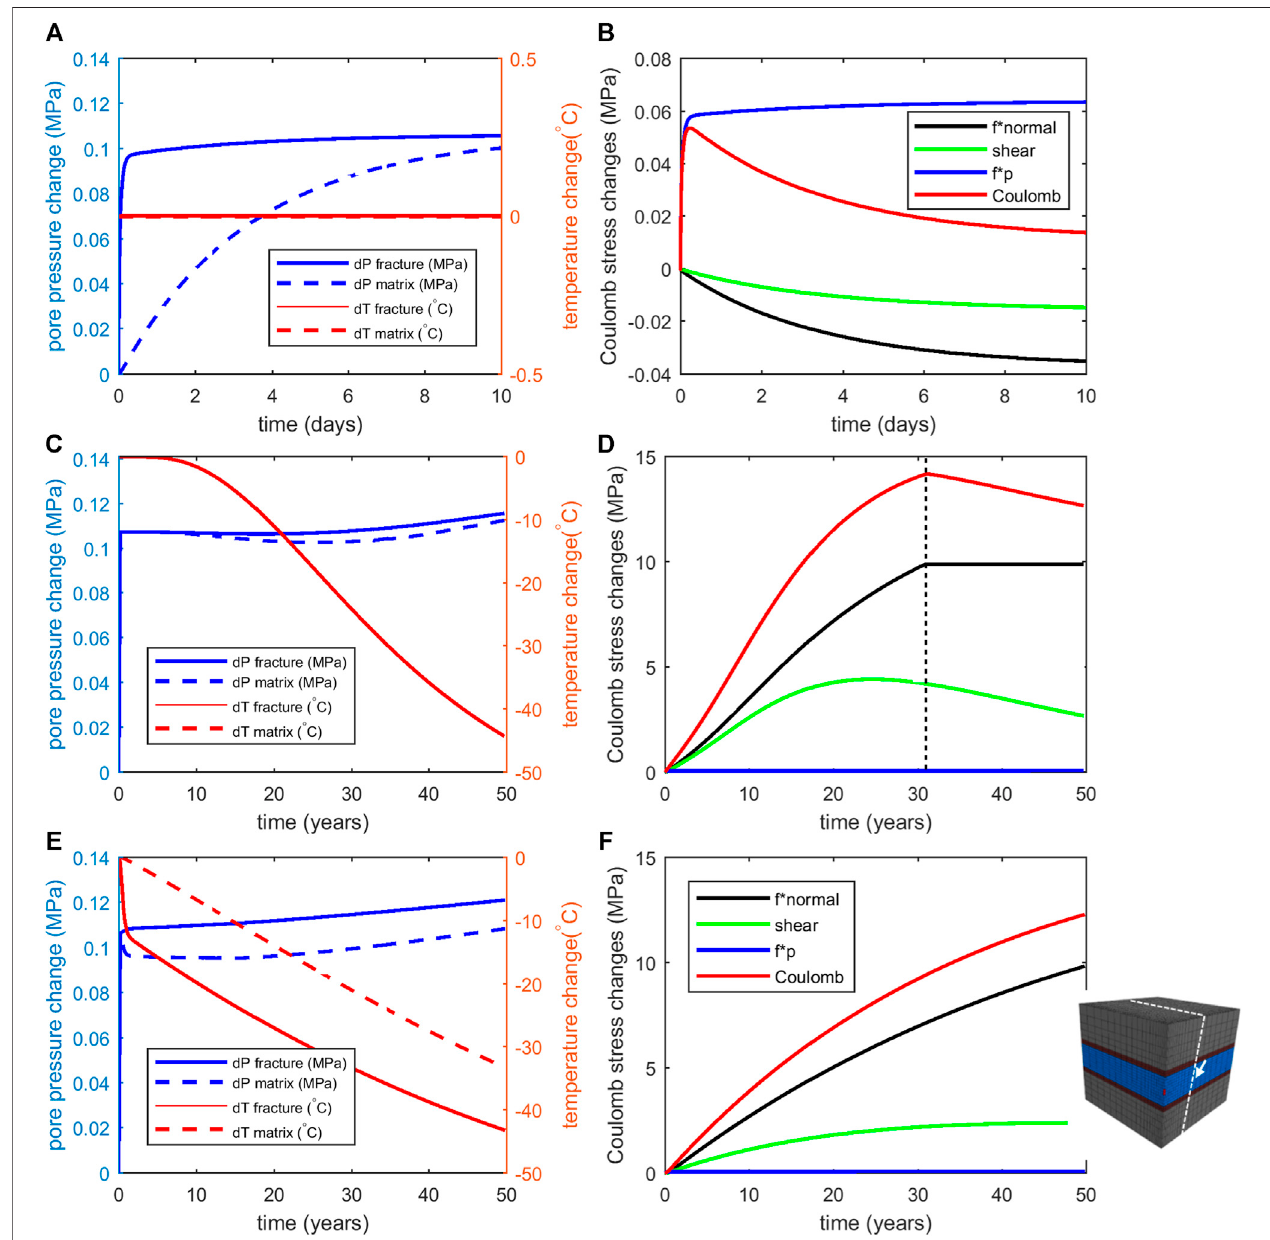
FIGURE 4 | Pressure and temperature changes on the fault (central, mid-height location) at 300 m distance from the injection well. (A) pressure and temperature changeduring fi rst10 days – fracturedistance200 m, (B) contributionofdirectpressureeffect(blue),totalnormalstresschanges(black),shearstress(green)toCoulomb stress change on the fault (red), fracture distance 200 m, during fi rst 10 days, (C) pressure and temperature change during total period of 50 years – fracture distance 2 m, (D) contribution of direct pressure effect (blue), total normal stress changes (black), shear stress (green) to Coulomb stress change on the fault (red), fracture distance2 m,duringtotalperiodof50 years.Dashedblacklineindicatesmomentnormalstressesbecometensile.Shearstressdeclinesafter25 yearsduetotheeffects of stress arching, (E) pressure and temperature change during total period of 50 years – fracture distance 200 m, (F) contribution of direct pressure effect (blue), total normal stress changes (black), shear stress (green) to Coulomb stress change on the fault (red), fracture distance 200 m, during total period of 50 years.